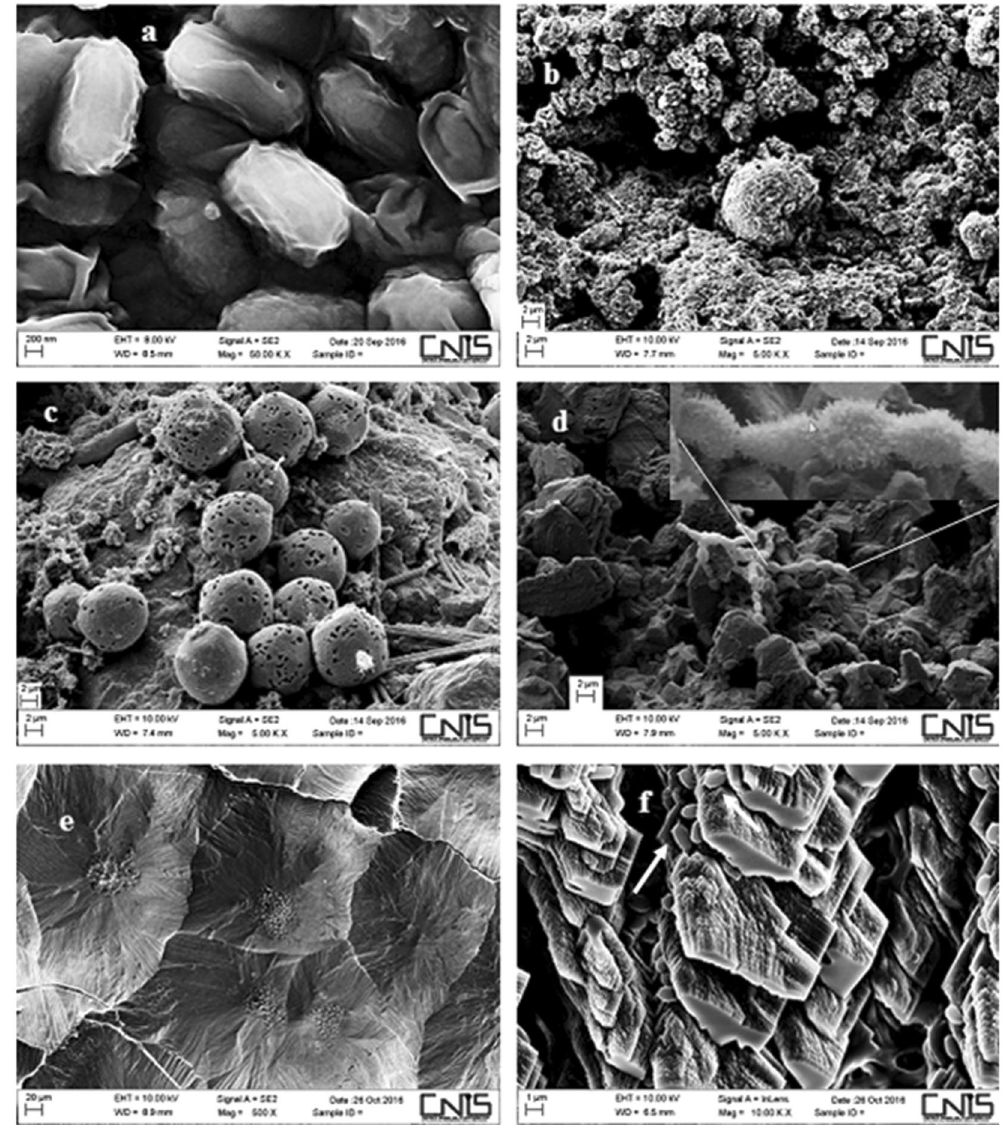
Figure 4. Scanning electron micrographs (SEM) of samples from the Tomba degli Scudi . ( a ) Purified spores from Bacillus cereus (sample 10) isolated from the white deposition of the western wall. ( b ) Spheroidal element from the western wall covered of white deposition (see also Fig. 1d) corresponding to CaCO 3 . ( c ) Spores of a mould from the thick white deposition of the eastern wall (see Fig. 1e). ( d ) A microorganism in the thick deposition in the eastern wall is producing CaCO 3 (see Figure S4b). ( e ) CaCO 3 produced by a pure culture of sample 7 grown on YPD supplemented with urea (see also Figure S6). ( f ) CaCO 3 produced by a pure culture of sample 10 in YPD supplemented with urea; white arrows indicate the spores of this microorganism mixed with the CaCO 3